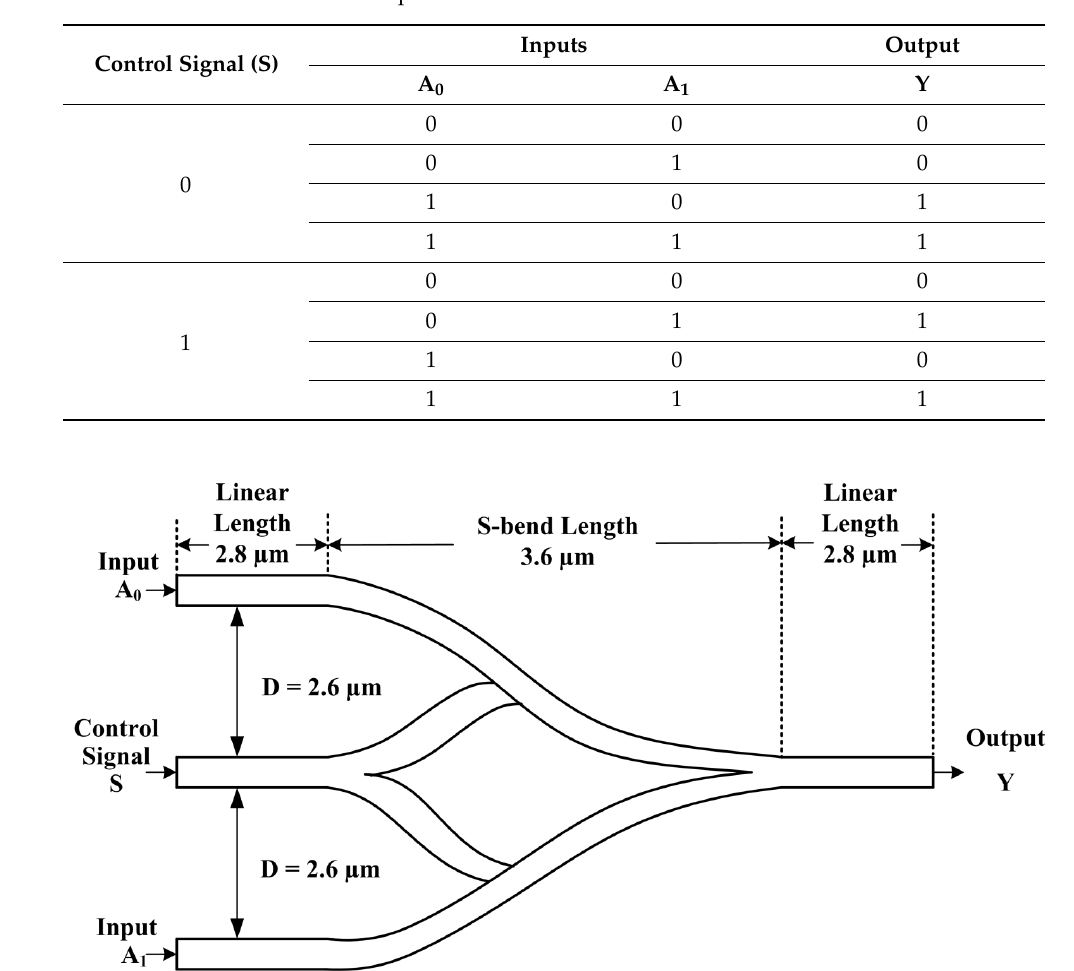
Table 1. Truth table of 2 × 1 multiplexer.